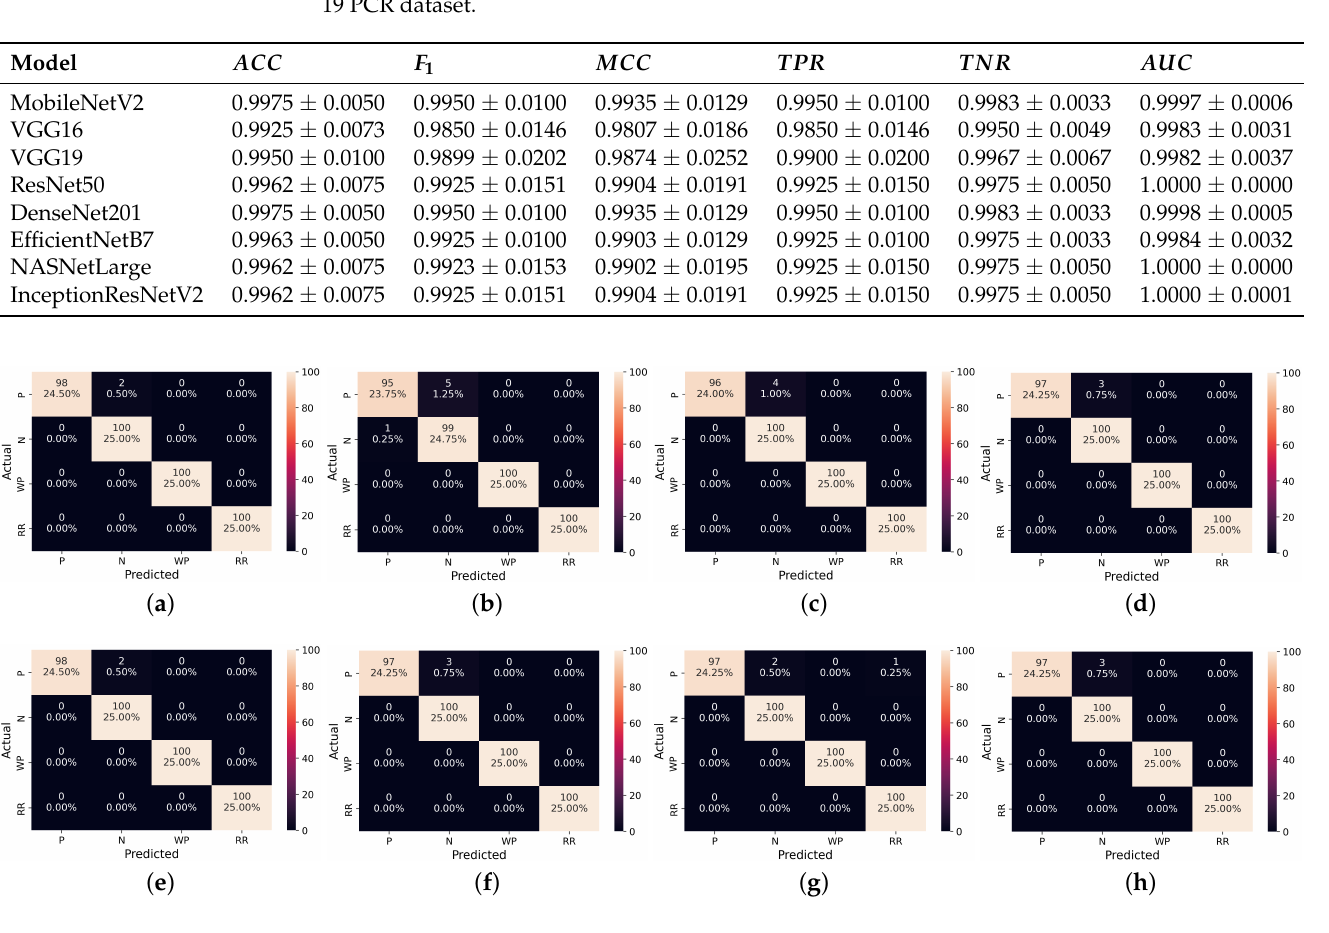
Figure 7. Confusion matrices obtained with 5-fold cross-validation for DCNN models. The upper number in each entry of the matrix is the overall number that the model predicts the corresponding classes from all testing folds, and the bottom number is the percentage, which refers to the overall number of test samples (400 patients). ( a ) MobileNetV2. ( b ) VGG16. ( c ) VGG19. ( d ) ResNet50. ( e ) DenseNet201. ( f ) InceptionResNetV2. ( g ) NASNetLarge. ( h )